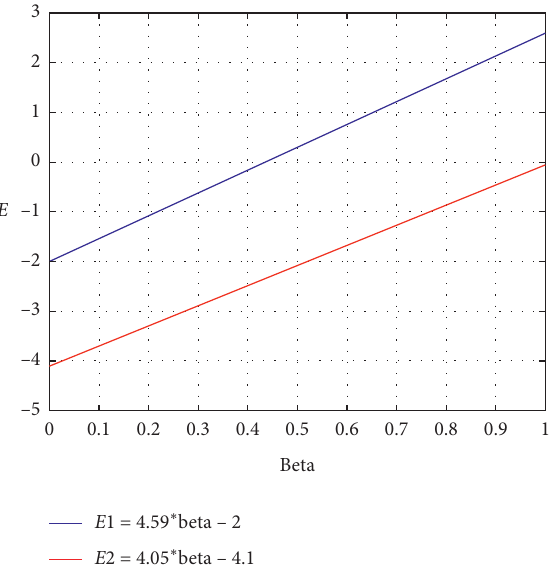
Figure 10: Function graphs of E C